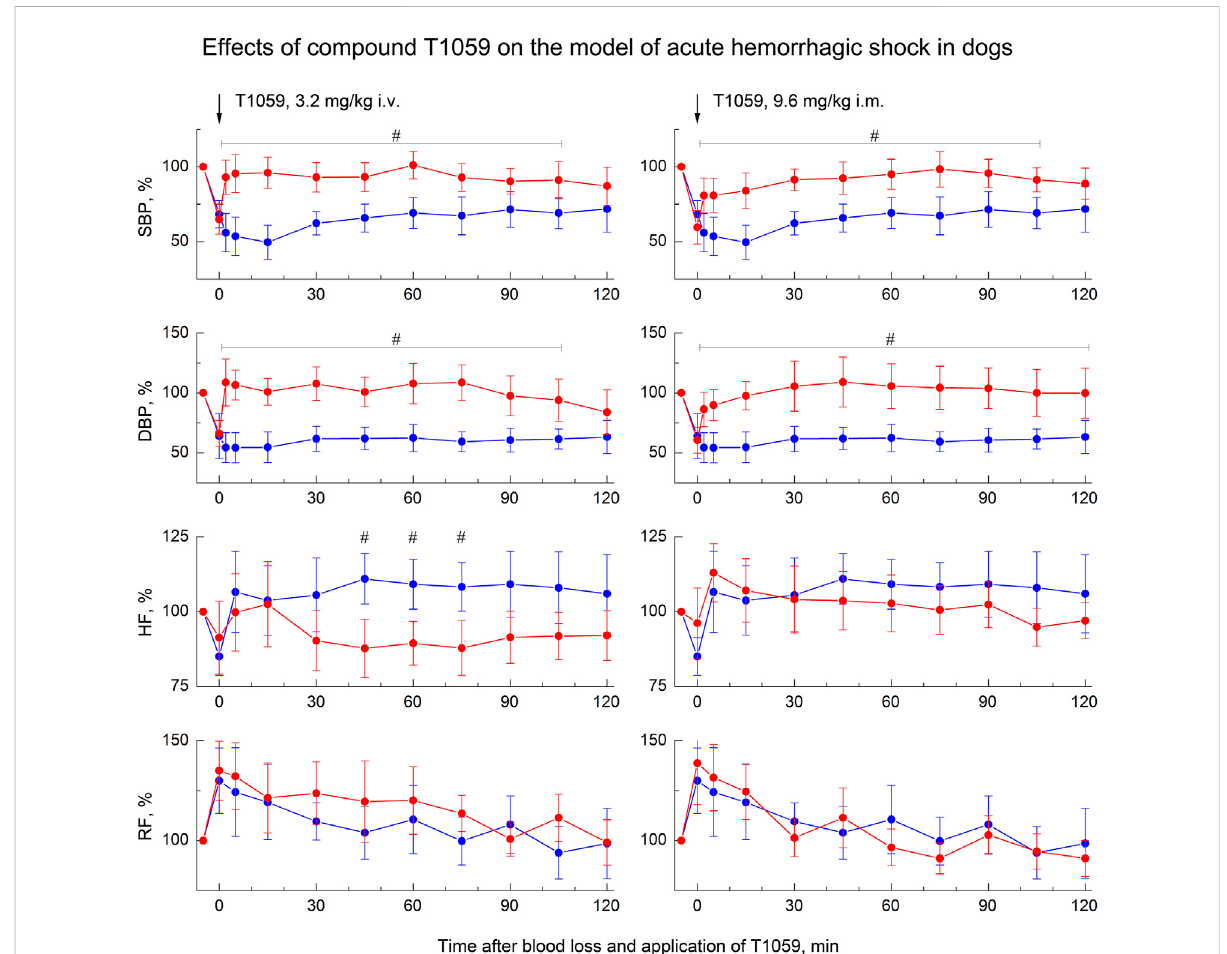
FIGURE 6 Effect of compound T1059 with a single i.v. injection at dose of 3.2 mg/kg (left) and a single i.m. injection at dose 9.6 mg/kg (right) on hemodynamicsandexternalrespirationofdogsatanearlystageofacutehemorrhagicshock.RedsymbolsandlinesareindicatorsofT1059-treated dogs ( n = 8), blue symbols and lines are indicators of untreated dogs ( n = 7). Data are normalized to the original values of indicators of animals and presented as percentage. Graphical deviations correspond to SD. # — signi fi cantly different indicators in untreated vs. T1059-treated dogs (3.2 mg/kg i.v, SBP: p = 0.00478, p = 0.00253, p = 0.00069, p = 0.00625, p = 0.00814, p = 0.00167, p = 0.01350, p = 0.03902, p = 0.02733, respectively. DBP: p = 0.00017, p = 0.00009, p = 0.00034, p = 0.00086, p = 0.00295, p = 0.00071, p = 0.00053, p = 0.00492, p = 0.01768, respectively. HF: p = 0.00745, p = 0.00908, p = 0.01362, respectively. 9.6 mg/kg i.m, SBP: p = 0.02176, p = 0.01892, p = 0.00354, p = 0.00513, p = 0.00940, p = 0.00874, p = 0.00721, p = 0.01956, p = 0.02498, respectively. DBP: p = 0.01572, p = 0.00743, p = 0.00209, p = 0.00651, p =